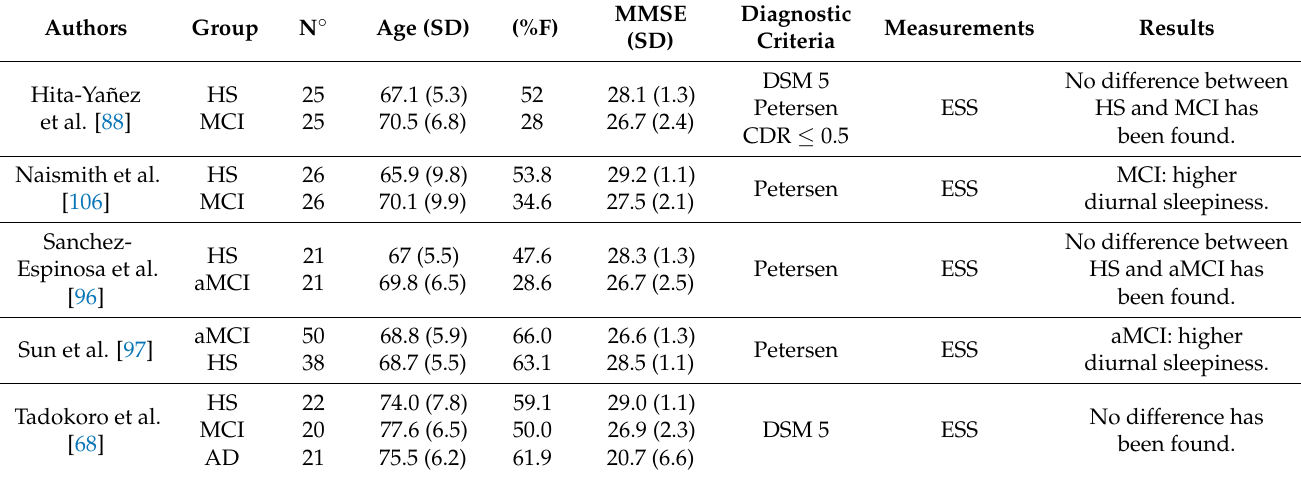
Table 9. Diurnal sleepiness in pathological older age. Summary of all the